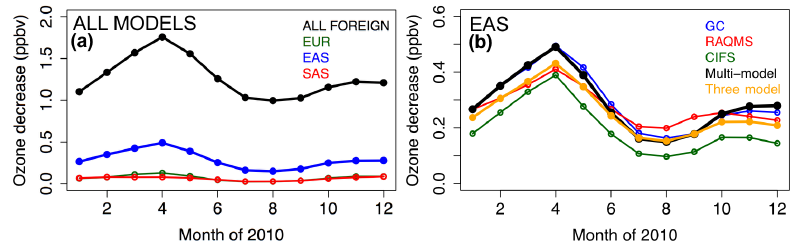
Figure 6. (a) North American (130–65 ◦ W; 20–50 ◦ N) mean O 3 sensitivity to 20% anthropogenic emission reductions in various non-North American regions, averaged from multiple (six–eight, see details in text) global models. (b) North American surface R (O 3 , EAS, 20%) values, as estimated by single (the three STEM boundary condition models) or multi-global model means. The “Multi-model” and “Three model” in the legend indicate the mean sensitivities of all eight global models and only of the three boundary condition models, respectively.